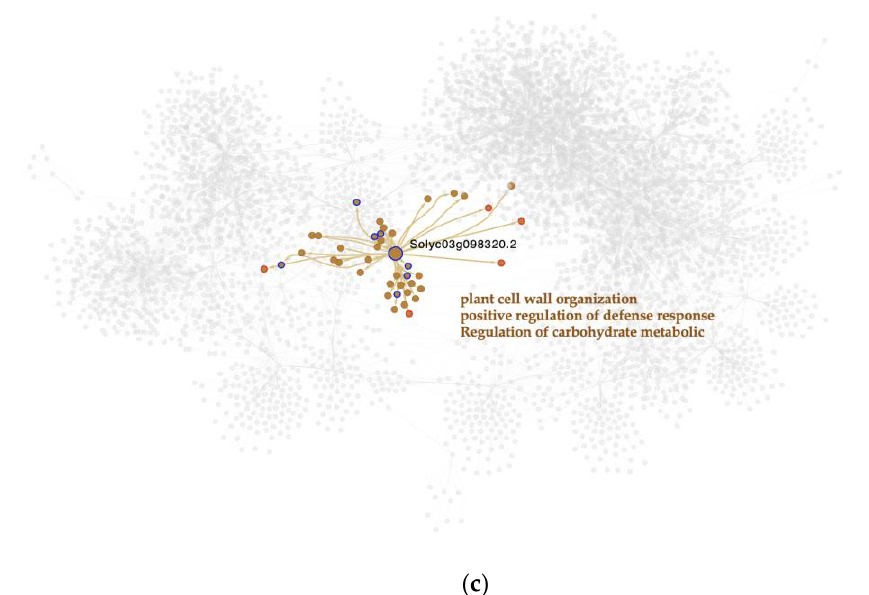
Figure 3. Interactome of the MYB-MTRs in the experimental conditions comparisons: ( a ) C. vs. S23 condition, ( b ) M. vs. S23 condition, ( c ) C. vs. M. condition. Each node represents a gene; the edges between nodes represent regulatory interactions between genes. The big, highlighted nodes with a specific color represent MYB-MTRs, while nodes of the same color surrounding these represent target genes regulated by an MTR. The most differentially expressed genes in each regulon have colored perimeters: blue for downregulation, red for upregulation. Enriched biological processes of each regulon are presented in the same color as the regulon. In the comparison C. vs. S23 MYB-MTRs are KUA1 (pink), MYB16 (green), and MYB1R1 (cherry red). Meanwhile, in the comparison M. vs. S23 MYB-MTRs are PHR1-like (aqua) and KUA1 (pink). For the M. vs. C. comparison, Solyc03g098320.2 (brown) is a MYB-MTR.